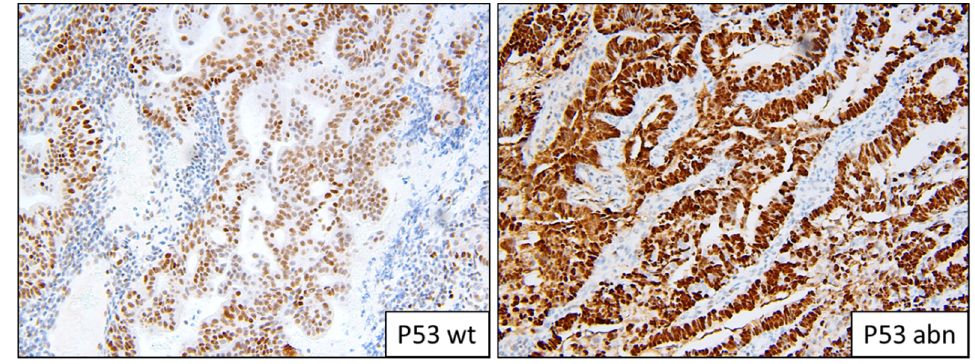
Figure 3. Example of p53 staining patterns; wild-type and abnormal overexpression.